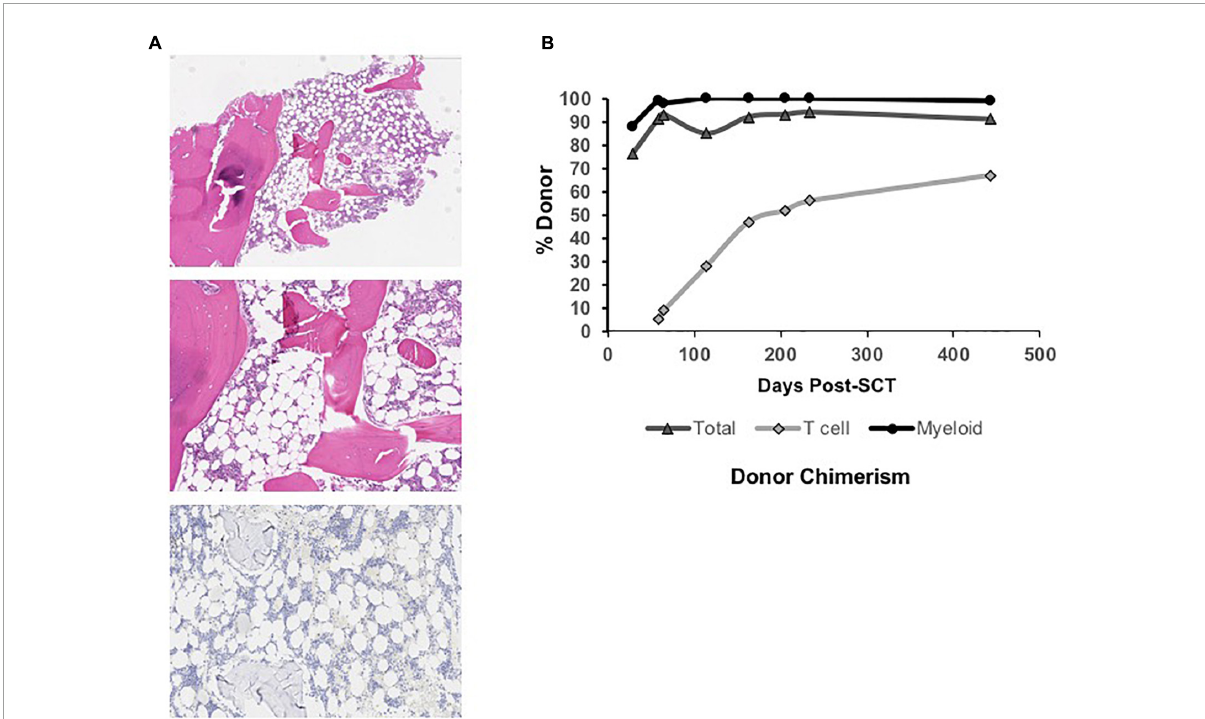
FIGURE1 (A) Low power view (Top) of hypocellular bone marrow biopsy ( ∼ 30% cellular) taken at 26 months of age (4x, H, and E stain) in the patient with MPL-mutant CAMT. Higher power view (Middle) of hypocellular marrow with myeloid and erythroid hematopoiesis and absence of megakaryocytes (10x, H, and E stain). Immunohistochemical stain for CD42b (platelet receptor for von Willebrand factor) is negative (Bottom), confirming absent megakaryocytes (10x). (B) Total, T cell, and myeloid donor chimerism through 14 months post-bone marrow transplant showing evolution to complete myeloid donor chimerism and rising donor T cell chimerism over